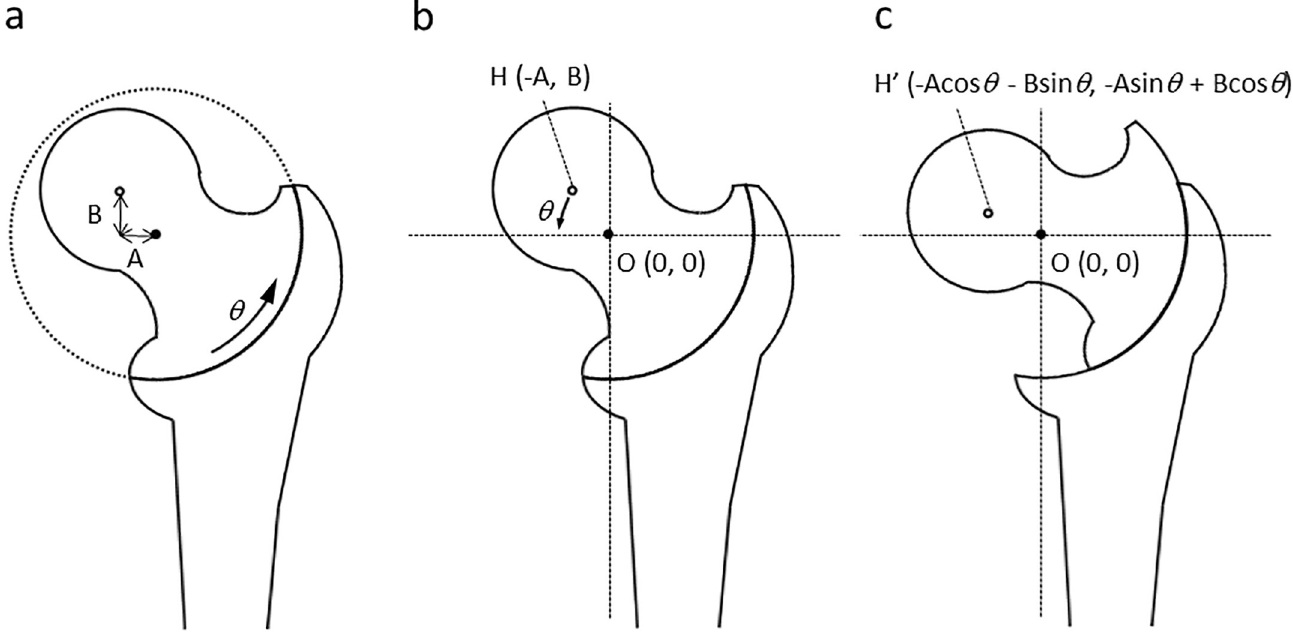
Fig 4. Diagram of mathematical model of curved intertrochanteric varus osteotomy. a) Black points show the center of the osteotomy arc (O), defined as a origin (0, 0). White points indicate the center of the femoral head (H). The lateral shift and distal shift of the center of the femoral head from origin are A and B, respectively. B) Before and c) after osteotomy; the coordinate of H changes as